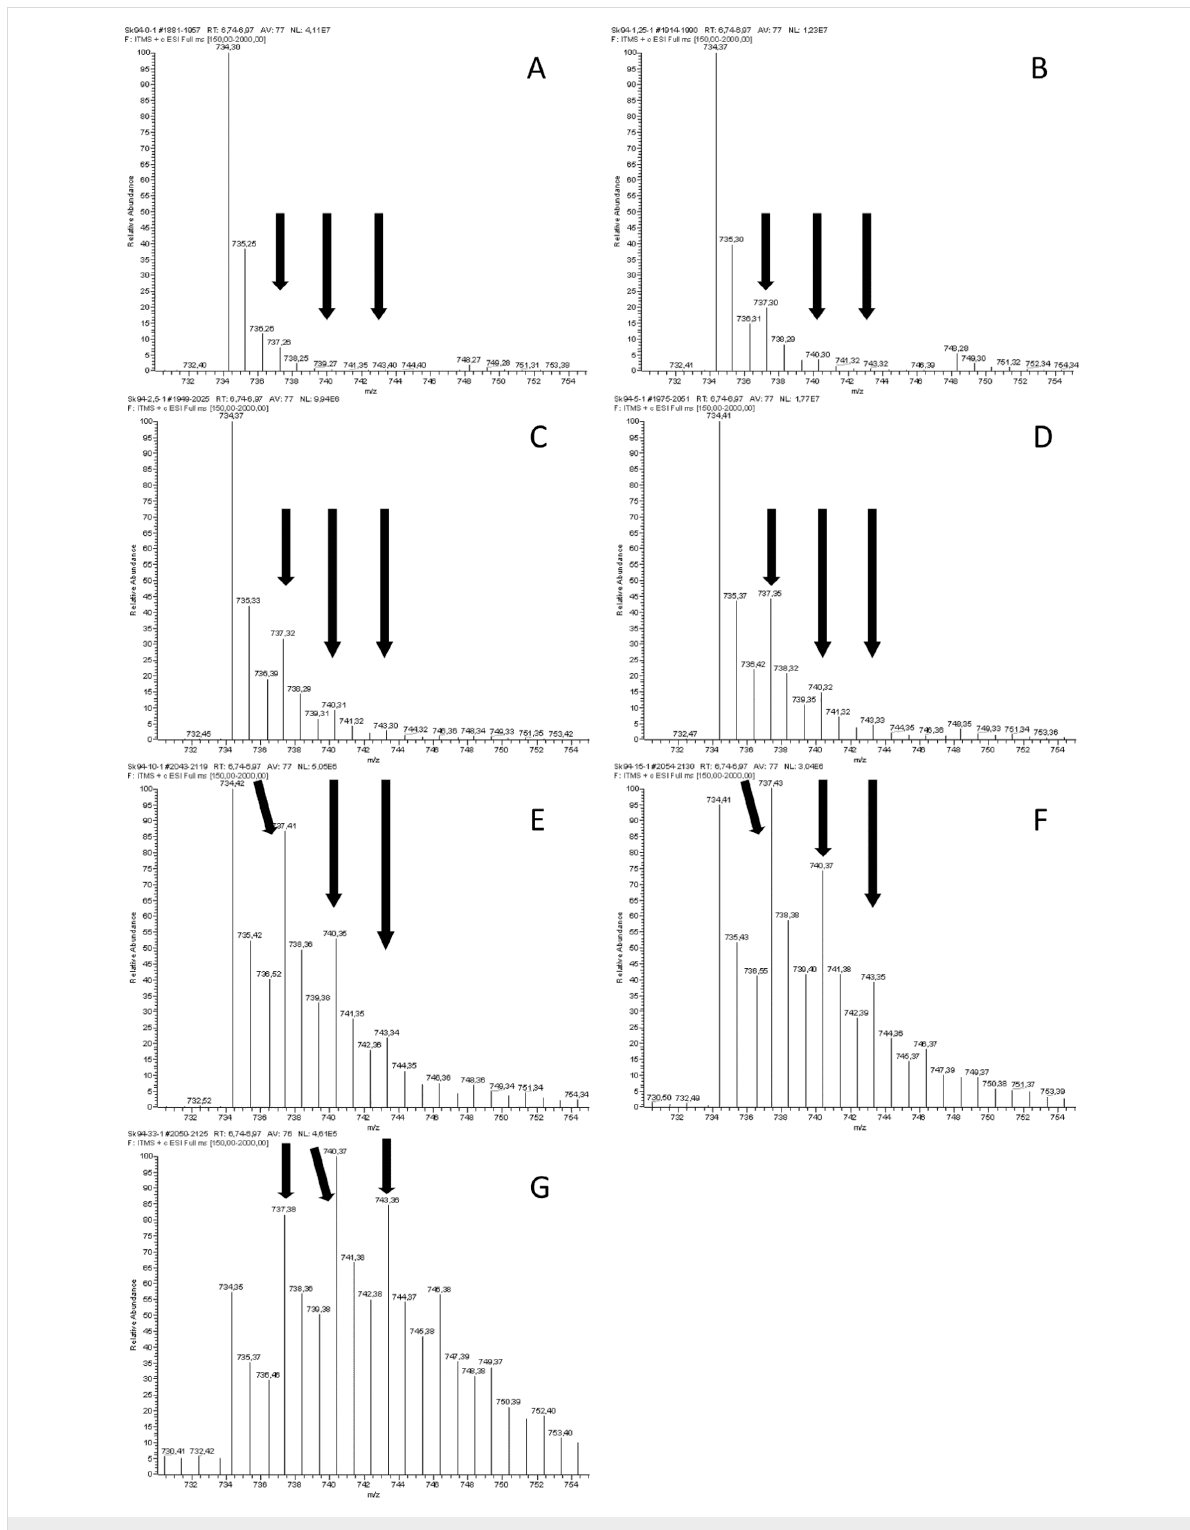
Figure 4: ESI–MS spectra of feeding experiments with an erythromycin-producing culture of S. erythraea . The mass spectra show the change in the isotope ratio of the detected erythromycin, depending on the concentration of 4 in the fermentation medium. (A) control, 0 mM 4 ; (B) 1.25 mM 4 ; (C) 2.5 mM 4 ; (D) 5 mM 4 ; (E) 10 mM 4 ; (F) 15 mM 4 ; (G) 30 mM 4 . The data are quantified by subtraction of the intensity of the mass for all relevant ions (beginning from 734.3 in steps of three, corresponding to the D 3 -label) of the control from the experiments. An analogous figure (Figure S9) for